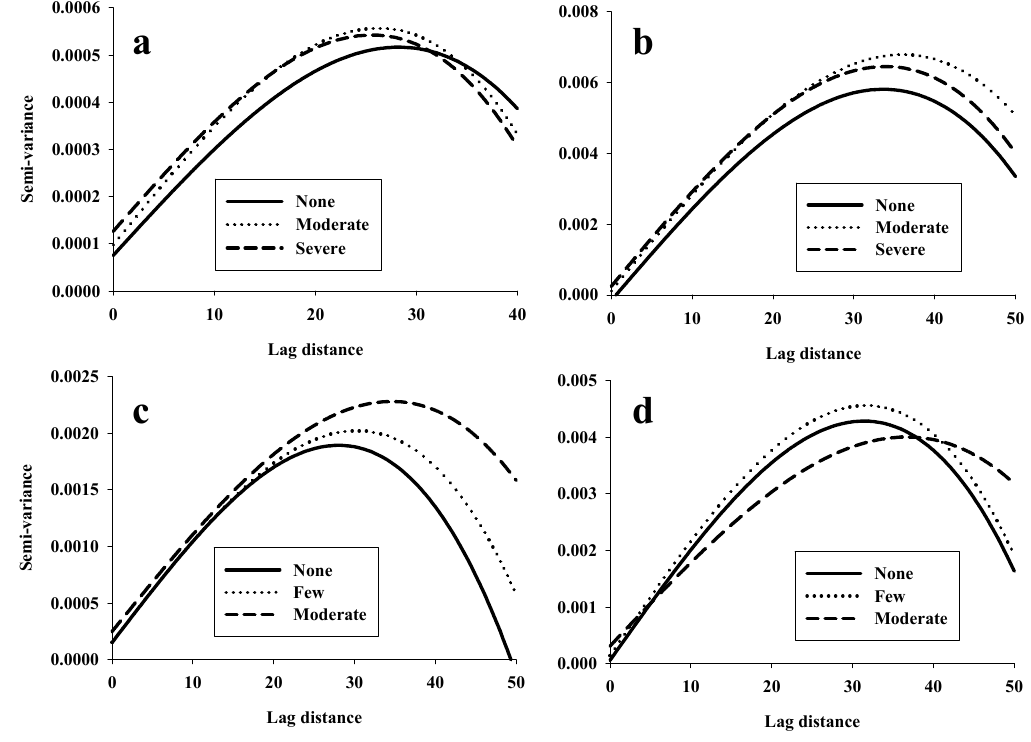
Figure 3. Variograms of reflectance data at 683 nm ( a ) and 775 ( b ) in response to abiotic stress, and at 731 nm ( c ) and 715 nm ( d ) in response to biotic stress.